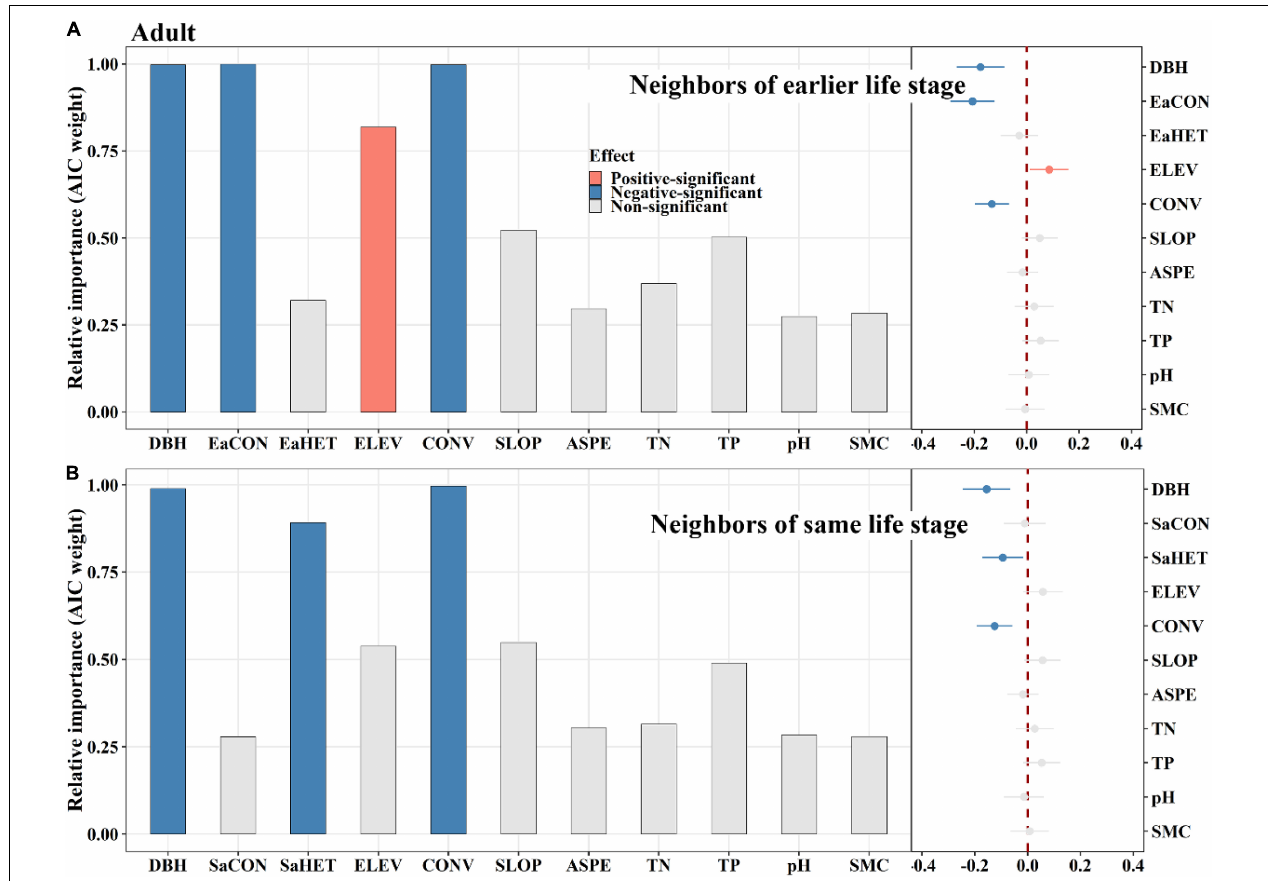
FIGURE 6 | The relative influence of potential variables including neighbors of earlier life stage (A) or neighbors of same life stage (B) on adult mortality. The variables examined are the log-transformed initial DBH of tree (DBH), conspecific neighborhood index at the earlier life stage (EaCON), conspecific neighborhood index at the same life stage (SaCON), heterospecific neighborhood index at the earlier life stage (EaHET), heterospecific neighborhood index at the same life stage (SaHET), environmental variables including elevation (ELEV), slope (SLOP), aspect (ASPE), convexity (CONV), total nitrogen (TN), total phosphorus (TP), pH value (pH) and ∧ ∧ β j ). Blue and red points indicate that parameter estimates differ moisture content (SMC) of soil. Error bars represent 1.96 s . e . j around the model-average estimator ( significantly from zero at the level of alpha =